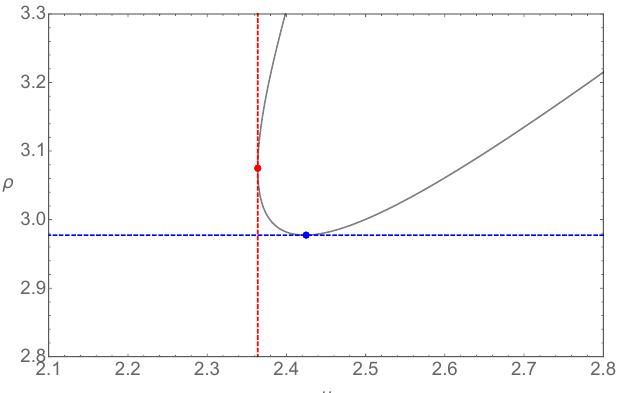
Figure 15 . The relation between the charge density ρ and the chemical potential µ . The derivative of this curve coincides with the charge susceptibility ∂ρ/∂µ and it is clearly negative between the blue and red dots. The latter corresponds to the turning points of the blue and red solid lines in the left panel of figure